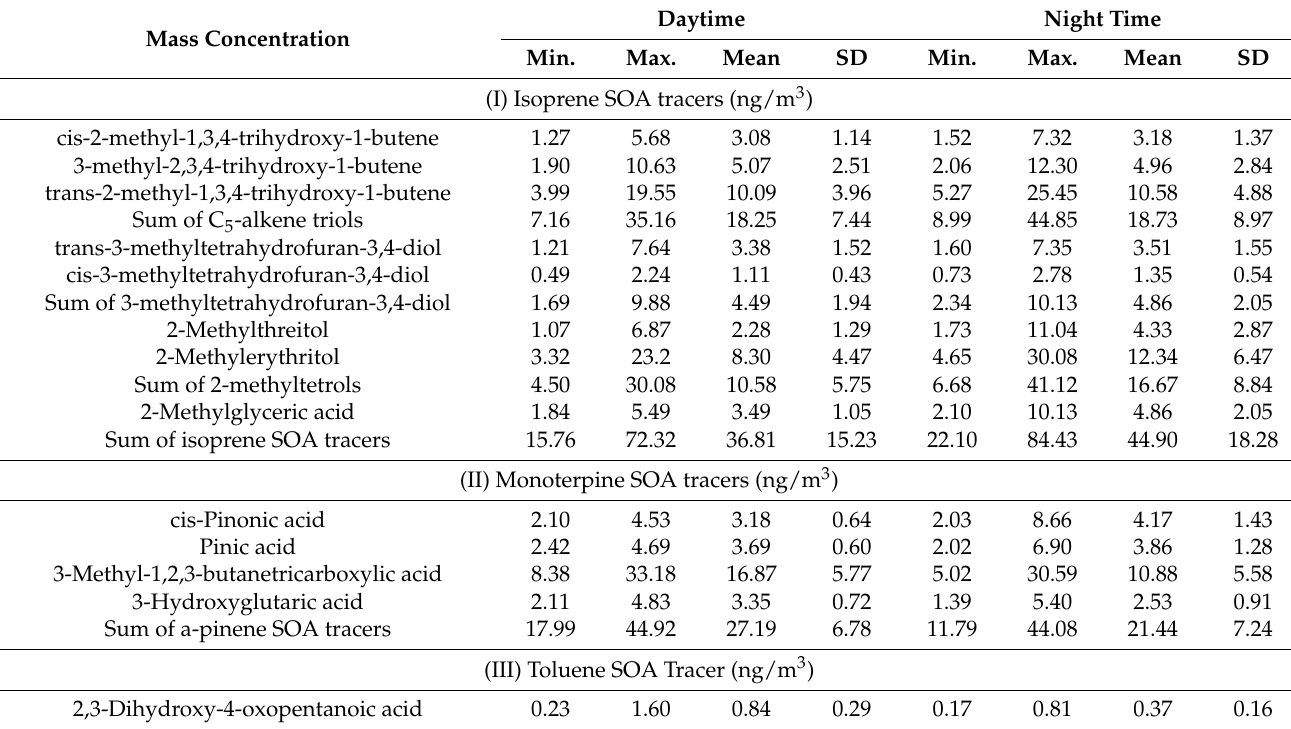
Table 2. Diurnal concentrations (ng/m 3 ) of biogenic SOAs in PM 2.5 during in Lincun. Mass